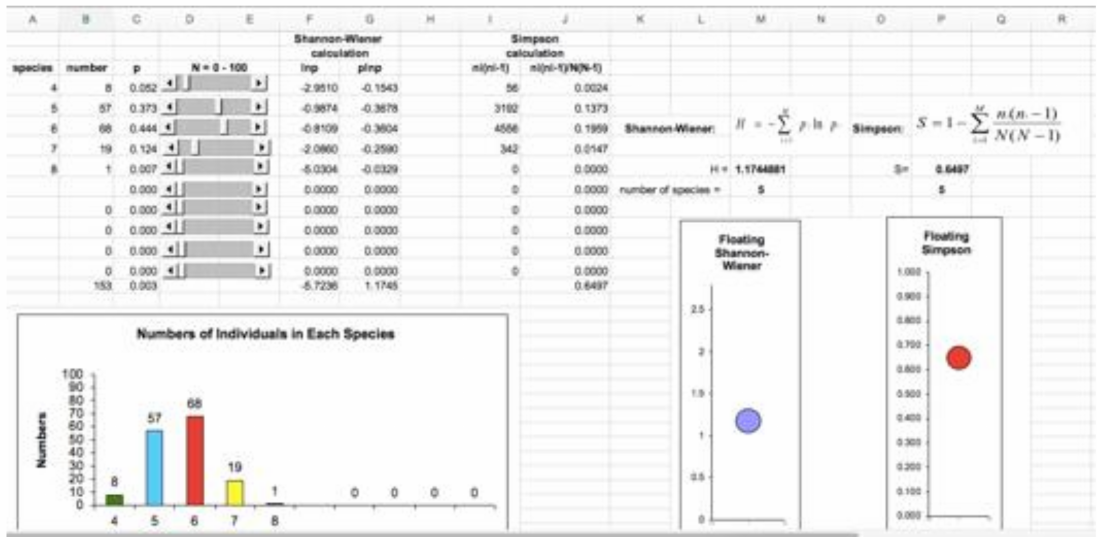
Figure 16. The distribution of sides per convex polygon type have used to calculate both Shannon and Simpson equations for diversity (Voronoi entropy in this case). The results are illustrated above from using our spreadsheet in the BioQUEST ESTEEM Collection